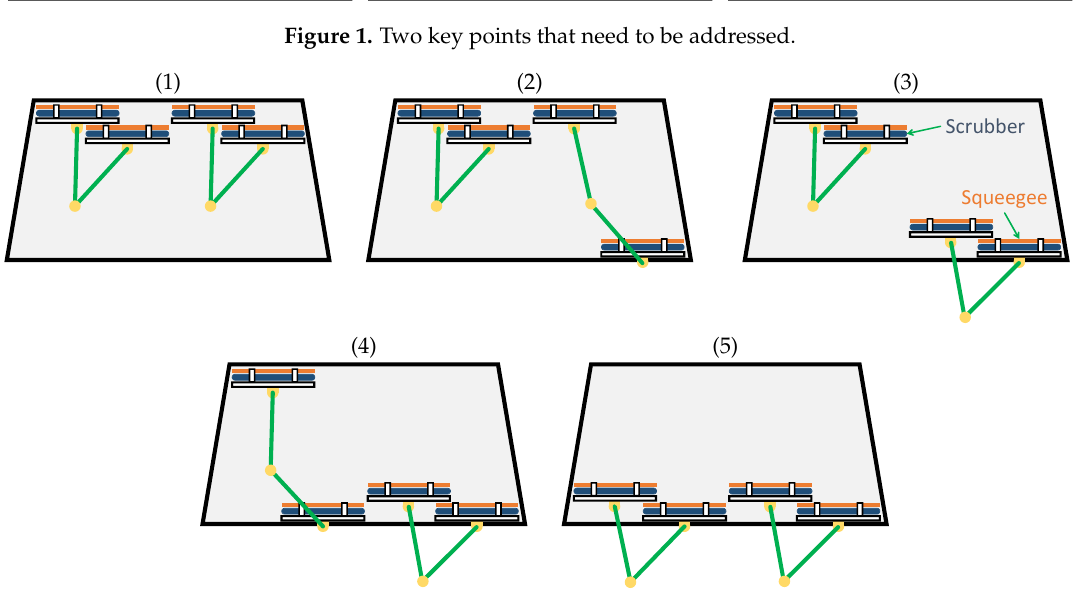
Figure 2. A biped robot adapts to distinct window frames. The process of our strategy is illustrated from ( 1 ) to ( 5